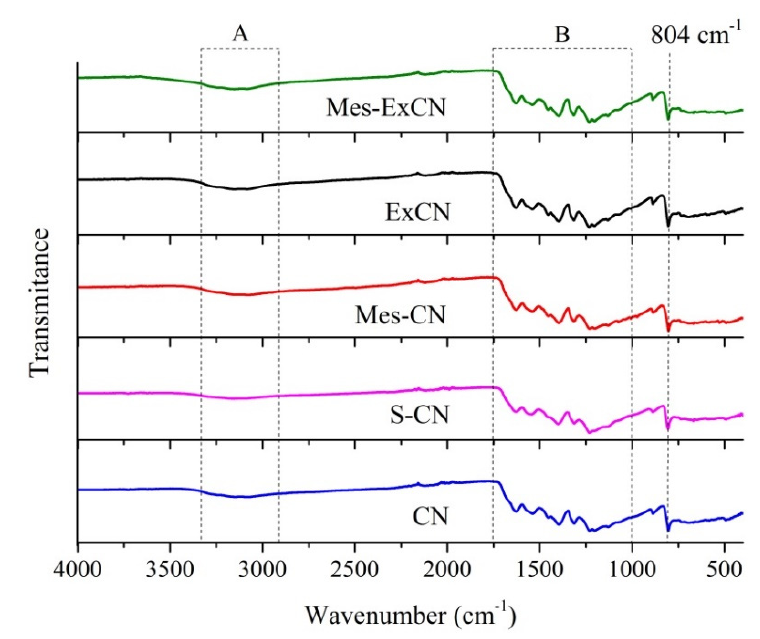
Figure 2. Fourier transform infrared spectroscopy (FTIR)-ATR spectra of CN-based nanomaterials.